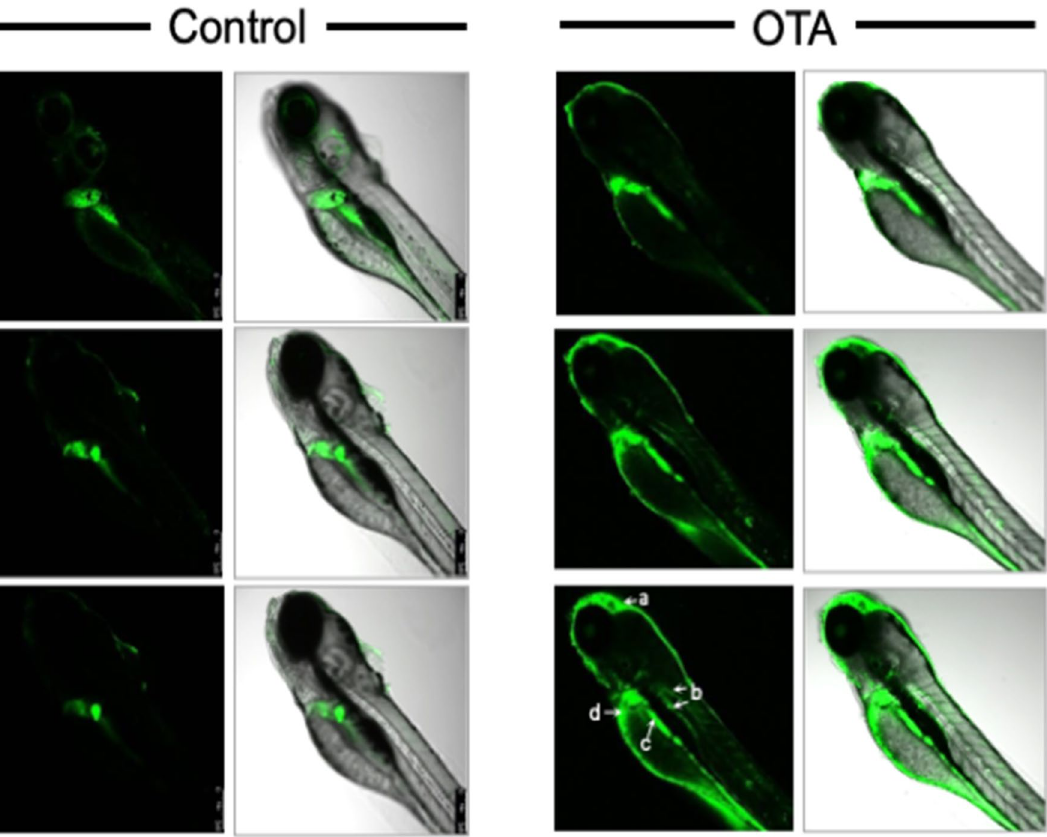
Figure 7. Localization of reactive oxygen species (ROS) production in zebrafish embryos exposed to OTA. ROS production was localized in zebrafish embryos (72 hpf) exposed to OTA (1 µM for 24 h) as compared to control embryos. Successive slices are shown through embryos (at 96 hpf) incubated for 60 min in CM-H2DCFA (10 μM) in rearing medium. Green fluorescence images (columns 1 and 3), and overlay with bright-field image (columns 2 and 4), are shown. As can be seen, increased ROS was clearly observed in brain (a), pronephric duct/ kidney (b), and intestine (c), as well as